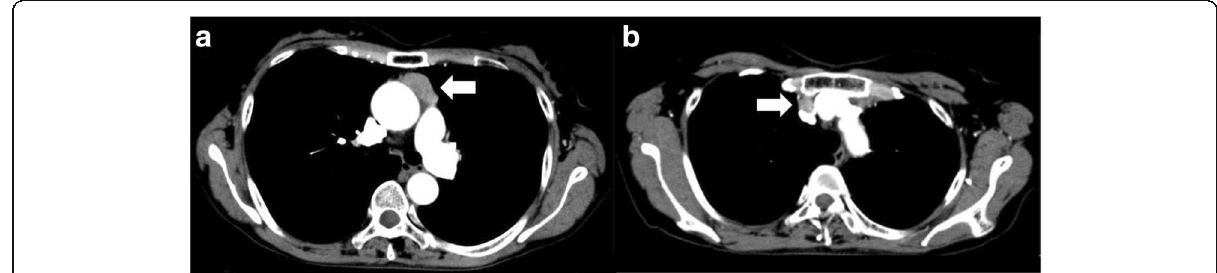
Fig. 1 Chest CT image. A tumor (30 × 30 × 14 mm) without invasion localized in the anterior mediastinum ( a ). Enlargement of lymph node ( b